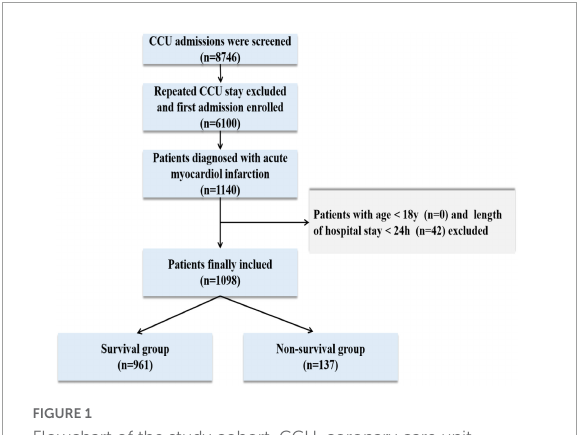
FIGURE1 Flowchart of the study cohort. CCU, coronary care unit.